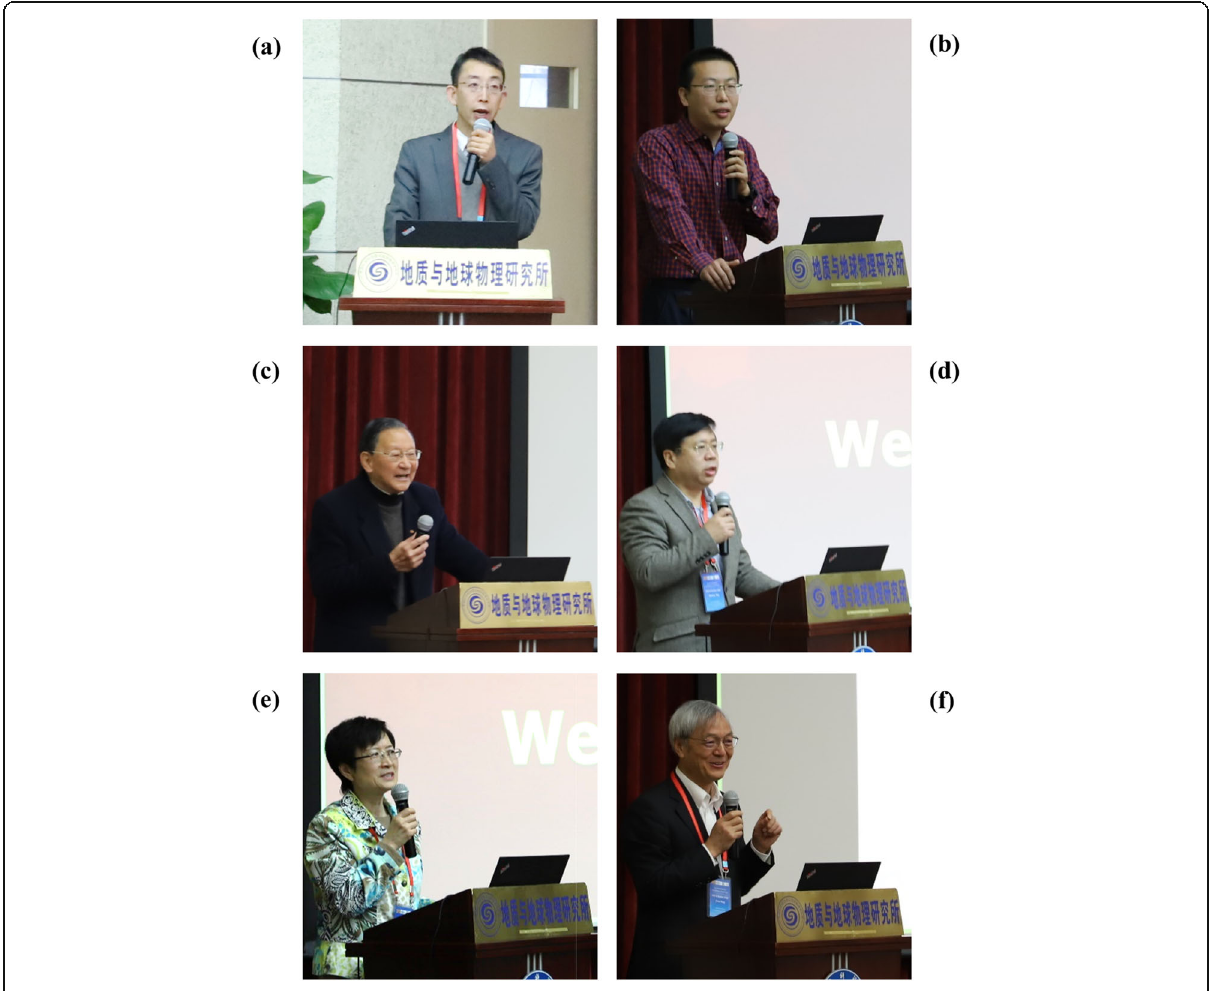
Fig. 1 Opening speech hosted by Prof. Shengwen Qi ( a) and presented by Dr. Xiaonan Duan ( b) , Prof. Jiyang Wang ( c) , Prof. Huiming Tang ( d) , Prof. Qingyun Di ( e) and Prof. Fawu Wang ( f)